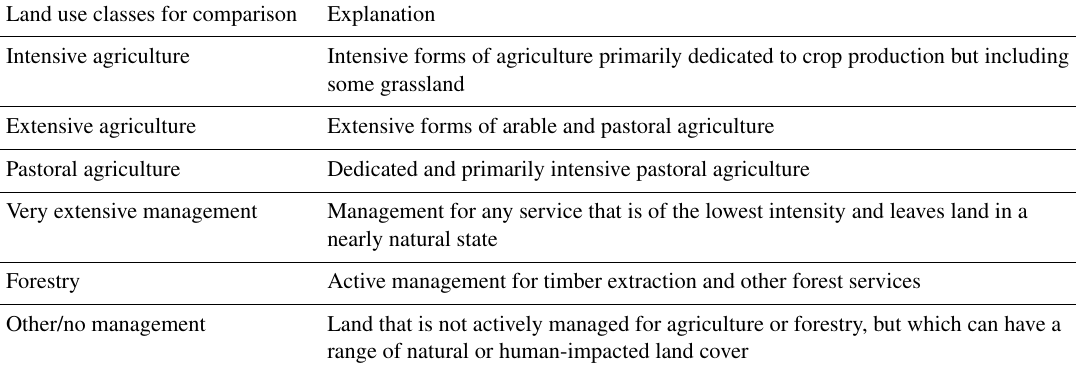
Table 4. Land use classes used in the comparison and their composition. Derivations from the full range of CRAFTY and IAP classes are given in Table